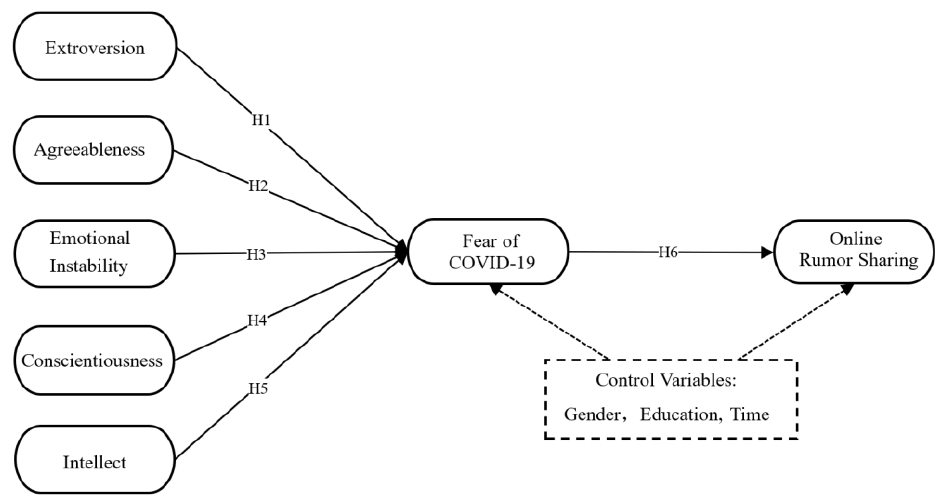
Figure 1. The research model. (Note: Time = Time spent on social media).